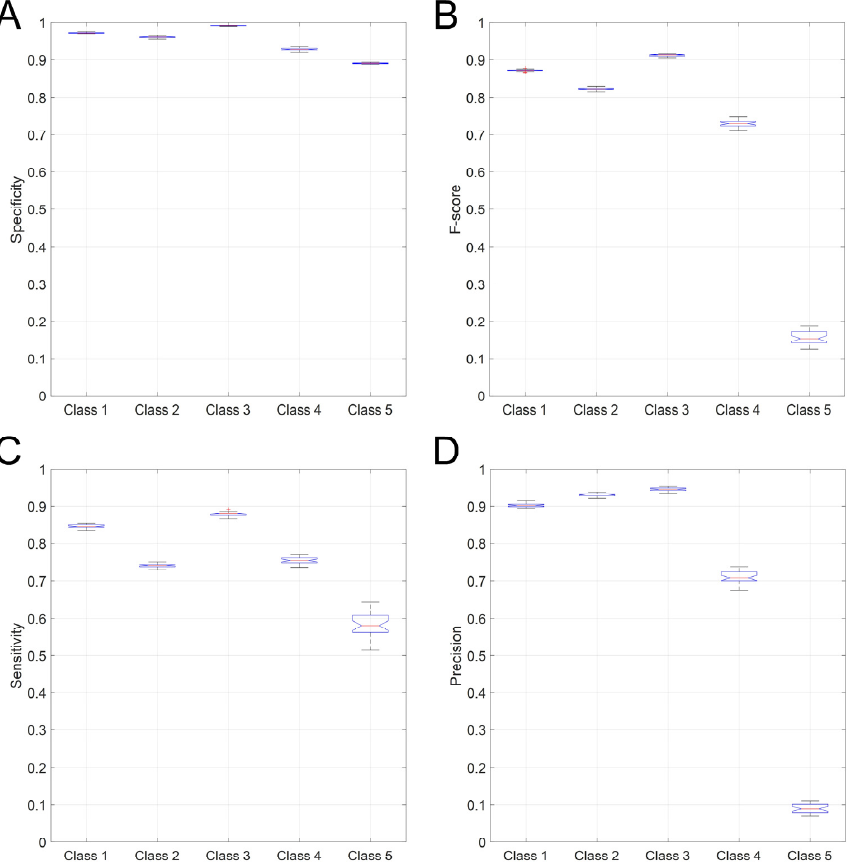
Figure 3. Specificity (panel ( A )), F-score (panel ( B )), Sensitivity (panel ( C )), and Recall (panel ( D )) are shown for the MLP optimized network 30 simulations. Each boxplot shows the median, the 25th and 75th percentiles, with the whiskers representing the maximum and minimum non-outlier values.